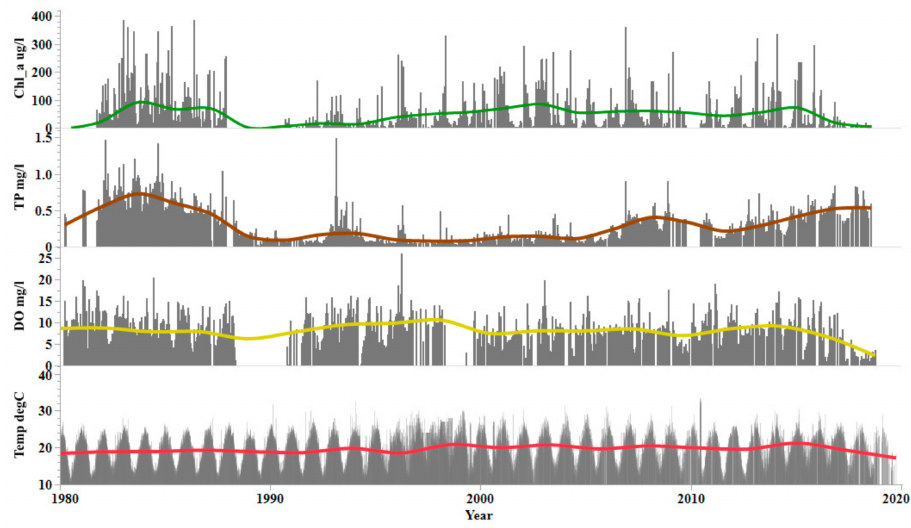
Figure 3. Time series of water quality parameters in the Hartbeespoort Dam;